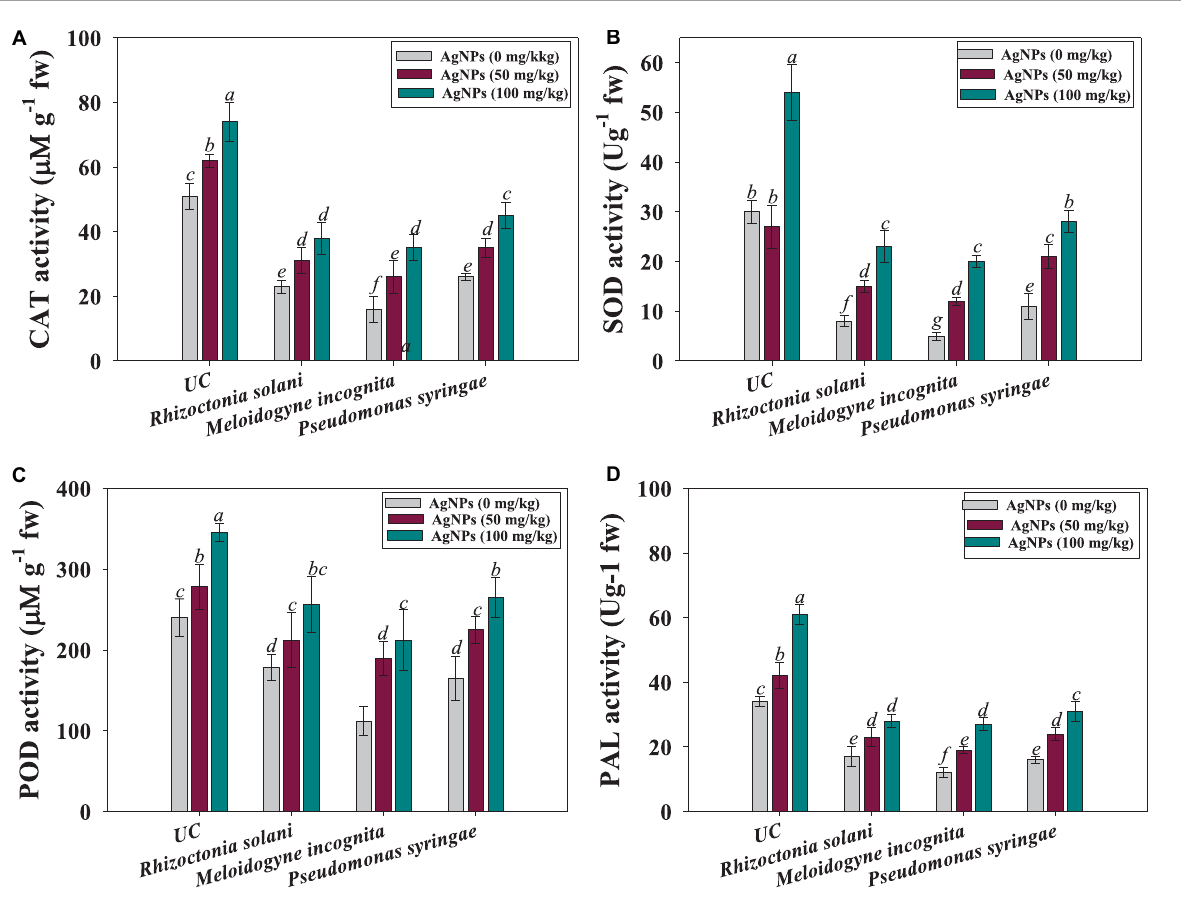
FIGURE6 Effect of Ag@ Cf L-NP son antioxidant enzymatic activities in leaf tissues of tomato crop cultivated in pot-soils infected with phytopathogens; M. incognita (root-knot nematodes) P. syringae (bacteria) and R. solani (fungi): catalase; CAT (A) , superoxide dismutase; SOD (B) , peroxidase; POD (C) and phenylalanine ammonia lyase; PAL (D) . In this figure, bar diagrams represents the mean values of three replicates ( n = 3). Corresponding error bars represents standard deviation (S.D) of three replicates (S.D, n =